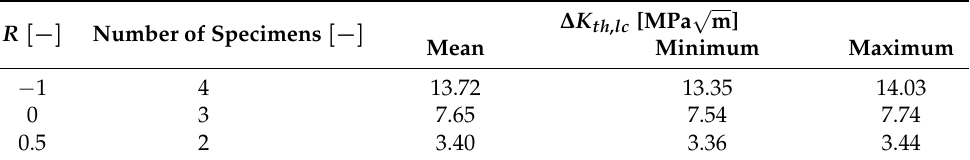
Table 3. Results of the evaluation of ∆ K th , lc for the investigated stress ratios.